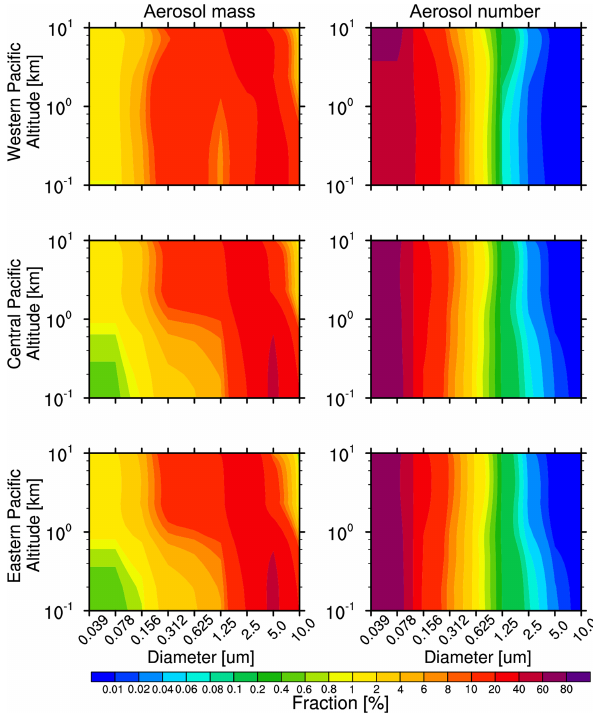
Figure 7. Vertical distribution of fractional contributions to the size of aerosol mass and number over the western, central, and eastern Pacific from the WRF-Chem simulation averaged for 2010–2014.